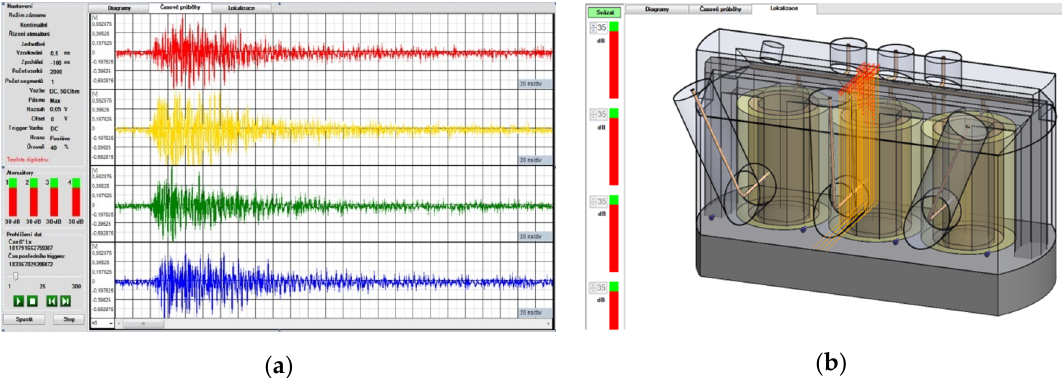
Figure 10. The software visualization of detected signal waveforms originating from discharge activity ( a ); the visualization of detected discharge activity in the localization module ( b ).